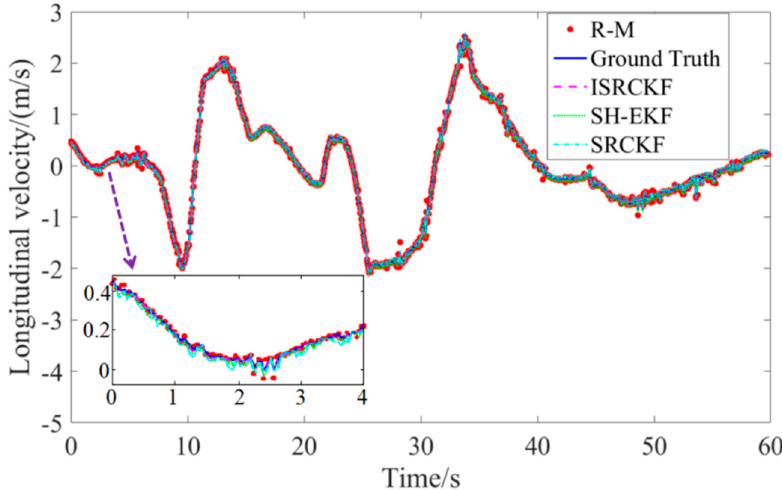
Figure 6. Target-vehicle longitudinal velocity time history curve.